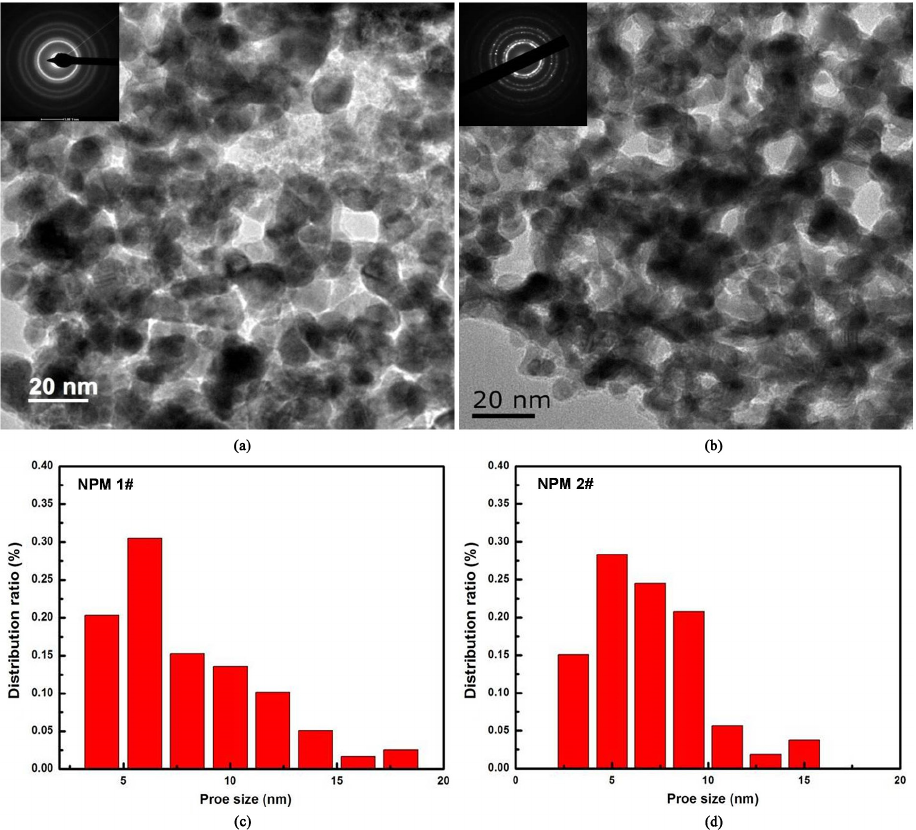
Figure 3. Bright-field TEM images of the NPM 1# (a) and NPM 2# (b), the insets are the SEAD patterns of the corresponding NPMs; the pore size distribution in NPM 1# (c) and NPM 2# (d).